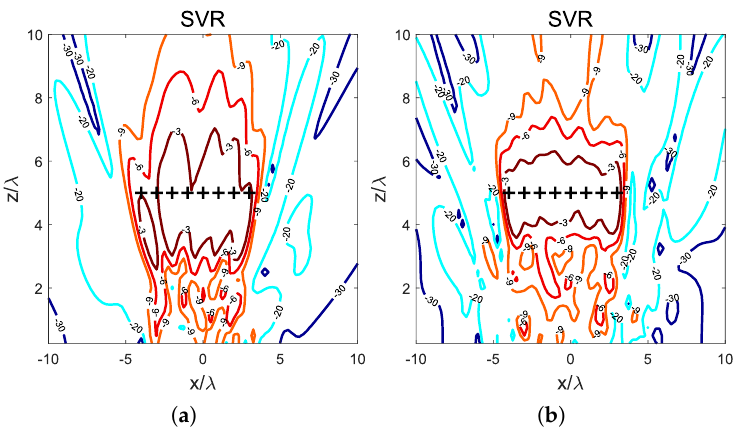
Figure 3. Example #2. Normalized near-field power density at y = 0 for the SVR method considering a coverage area defined by the assigned focal points represented by the symbol +. The number of elements of the array is 12 × 12 separated 0.6 λ in ( a ) and 16 × 16 separated 0.7 λ in ( b